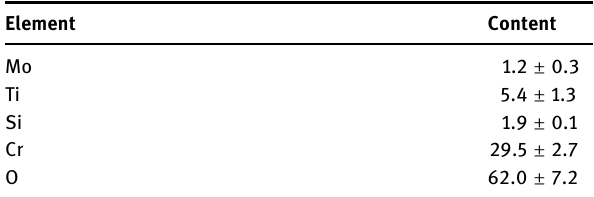
Table 3: Composition of the light gray phase in the oxide scale in Figure 9 ( c ) ( at%